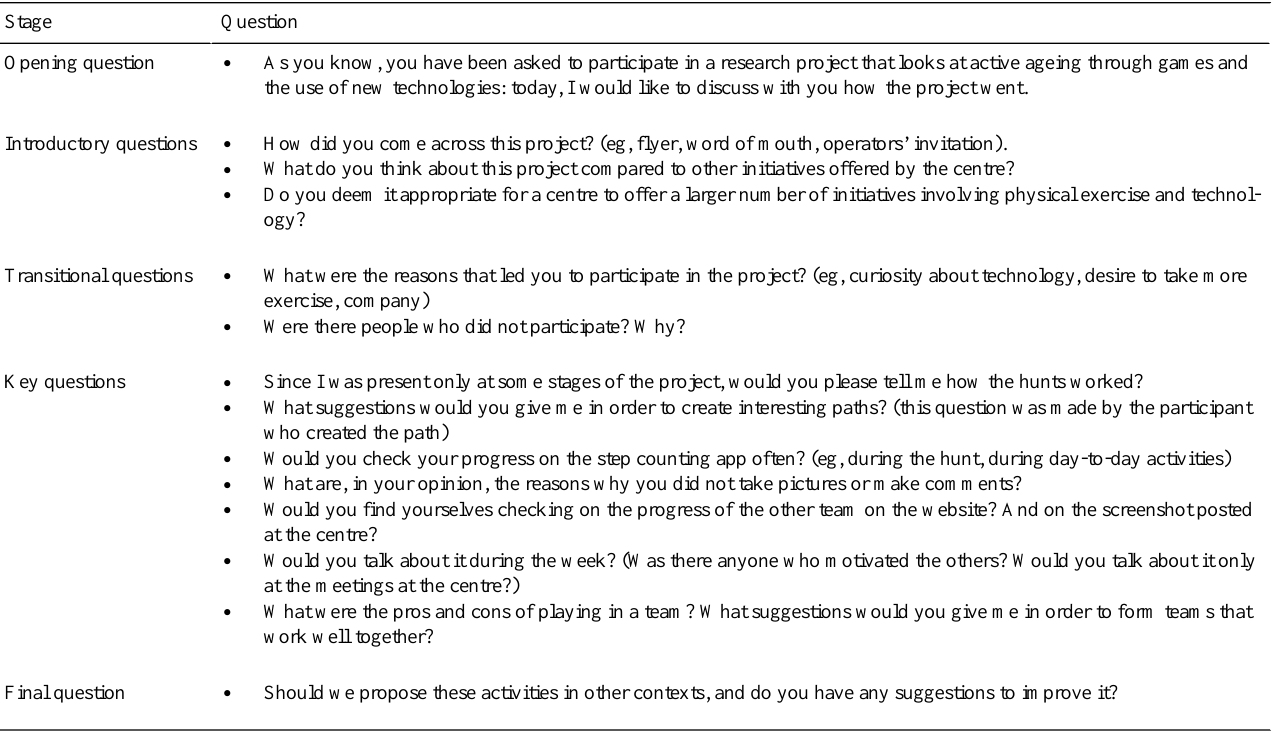
Table 2. Focus group discussion